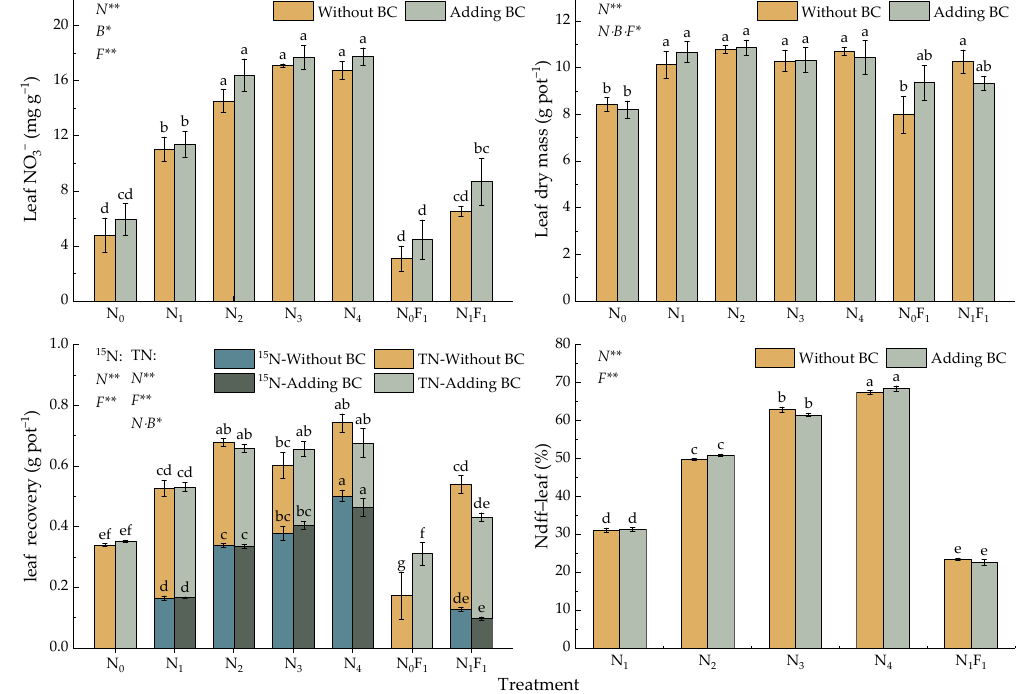
Figure 2. Leaf NO 3 − , Dry mass, 15 N recovery and its proportion. Note: Vertical bars represent standard errors of the means (n = 5). Different letters represent statistical class among the treatments at p < 0.05, and the presence of means with the same letter is not significantly different. Source of variation, N = 15 N-labeled urea; B = brown coal; F = organic manure. * and ** indicate significant differences at p < 0.05 and p < 0.01, respectively. N 0 , N 1 , N 2 , N 3 , and N 4 represent the urea application rate, 0, 100, 200, 300, and 400 kg N ha − 1 , respectively. F 1 represents organic manure of 100 kg N ha − 1 .